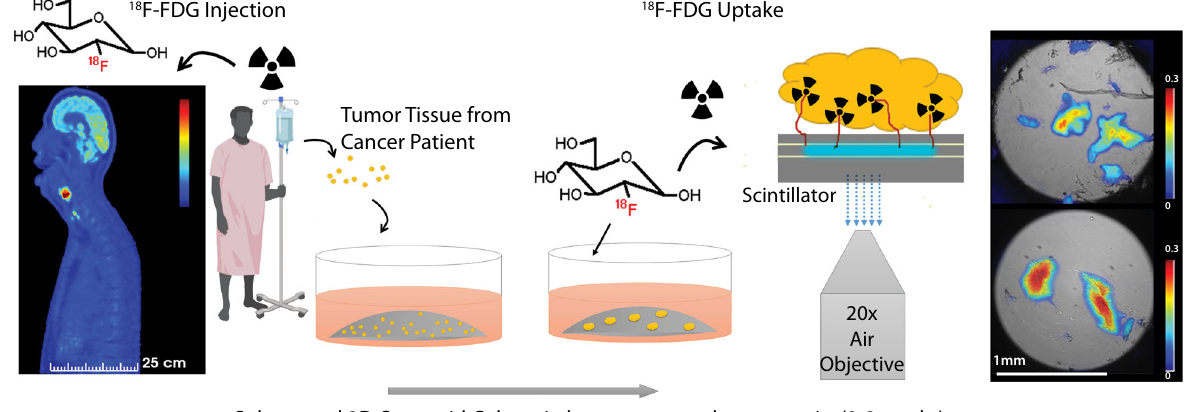
Fig. 1 Schematic representation of the oPEM work fl ow. Tumor organoids were cultured for 2 – 3 weeks in a submerged basement membrane matrix culture system. Patient-derived organoids (right) were imaged with high resolution using FDG, a radiotracer commonly used in the clinic for diagnosis and staging of head-and-neck cancer patients (left). The organoids were placed on thin inorganic scintillators and the resulting scintillation light was imaged with a highly sensitive microscope through a ×20 objective lens. The scale bars of PET and oPEM images highlight the large difference in image resolution. The color bar shows radioactivity (Bq/pixel) inside tumor